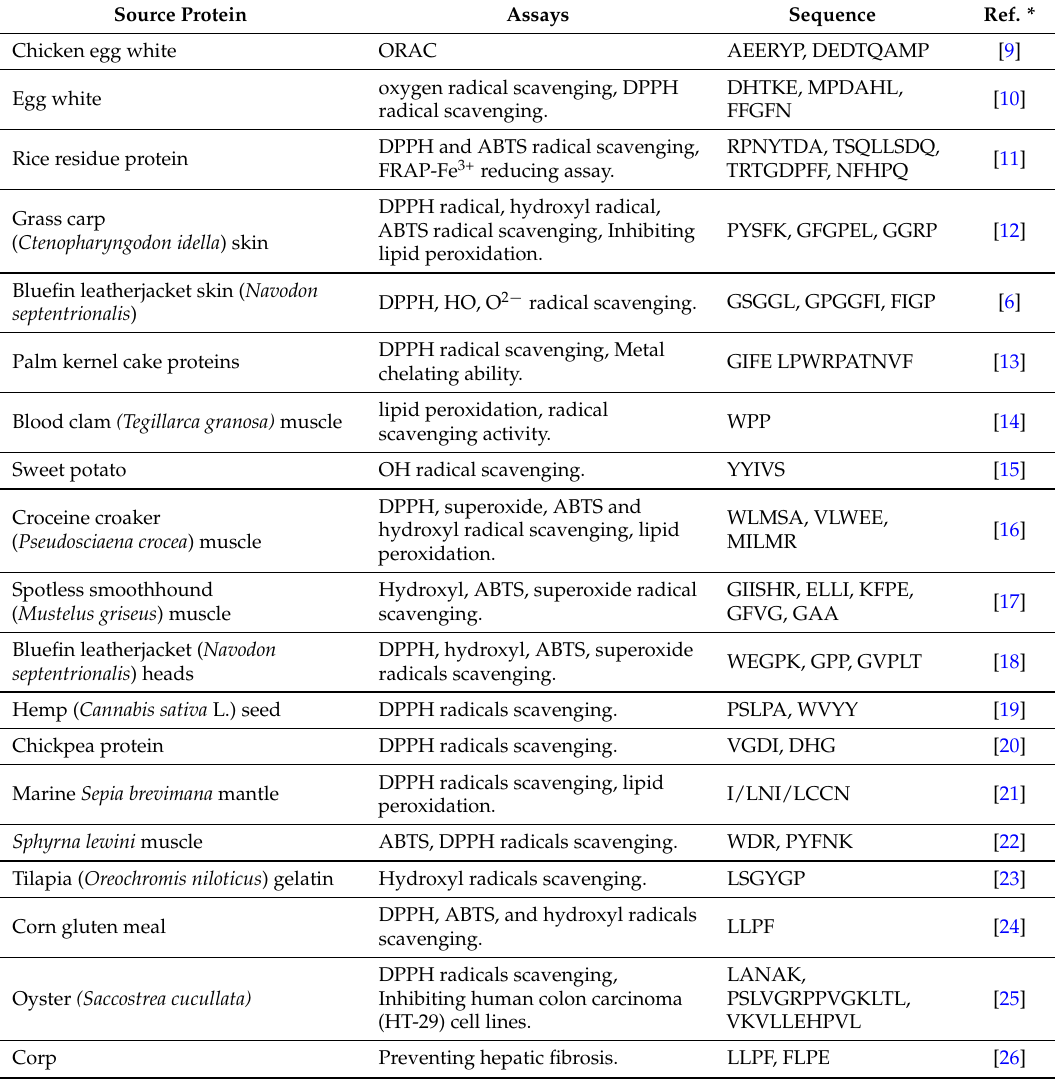
Table 1. Sources, evaluation assays, and amino acid sequences of antioxidant